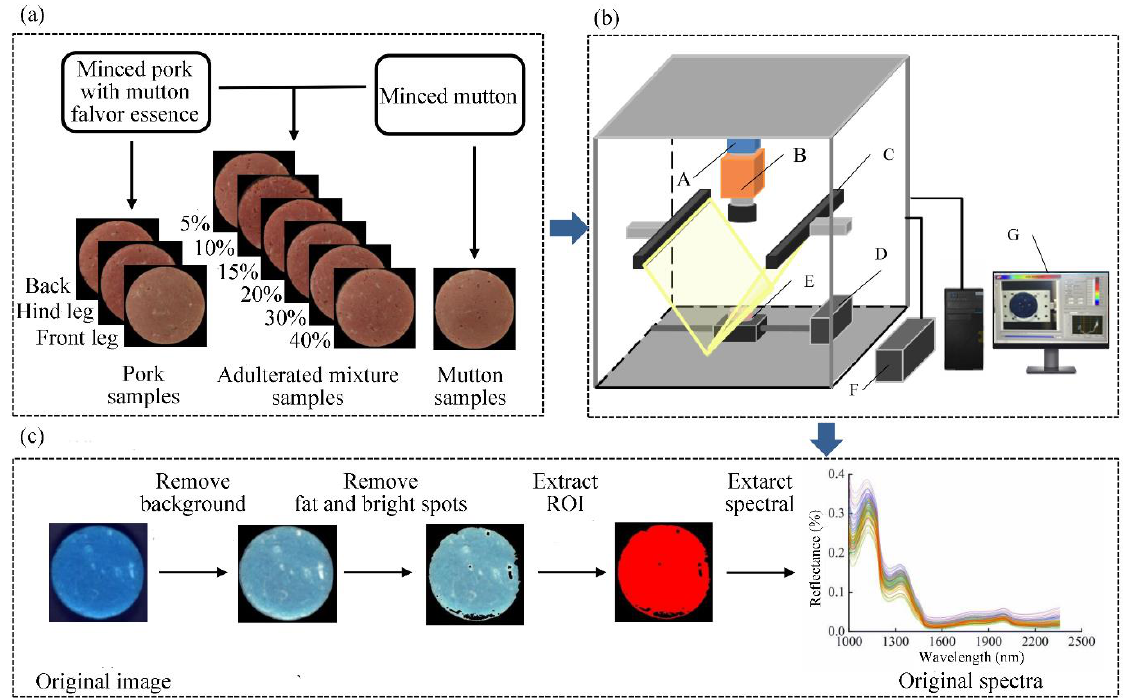
Figure 1. Schematic representation of sample preparation (a), NIR-HSI system (b) and spectral acquisition (c). (A) CCD camera; (B) imaging spectrograph; (C) light source; (D) electric moving stage; (E) sample; (F) light source controller; (G) computer and sample image. ROI: region of interest. NIR-HSI: near-infrared hyperspectral imaging.